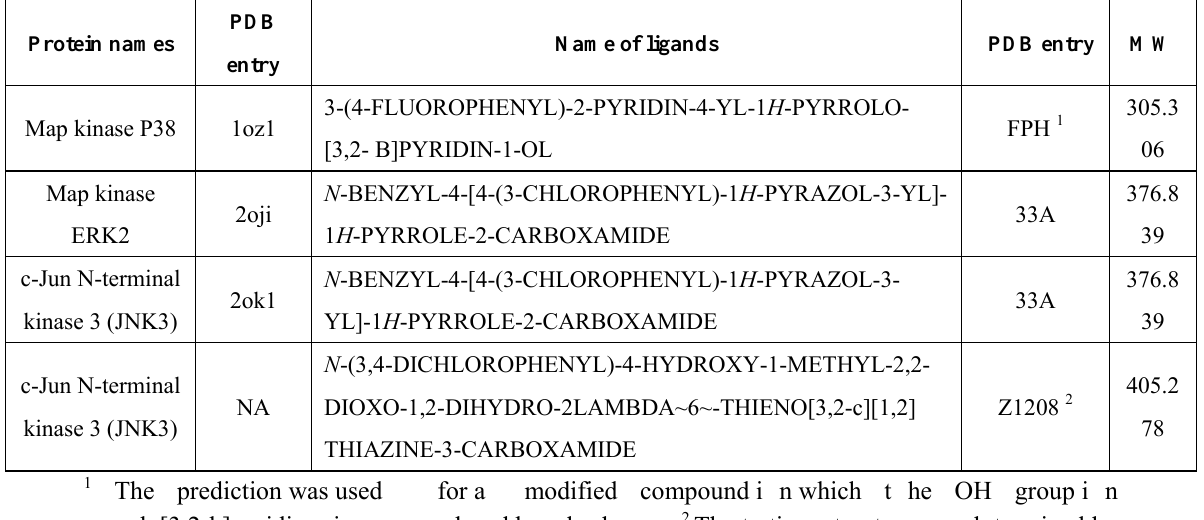
Table 1. Proteins and ligands used in this